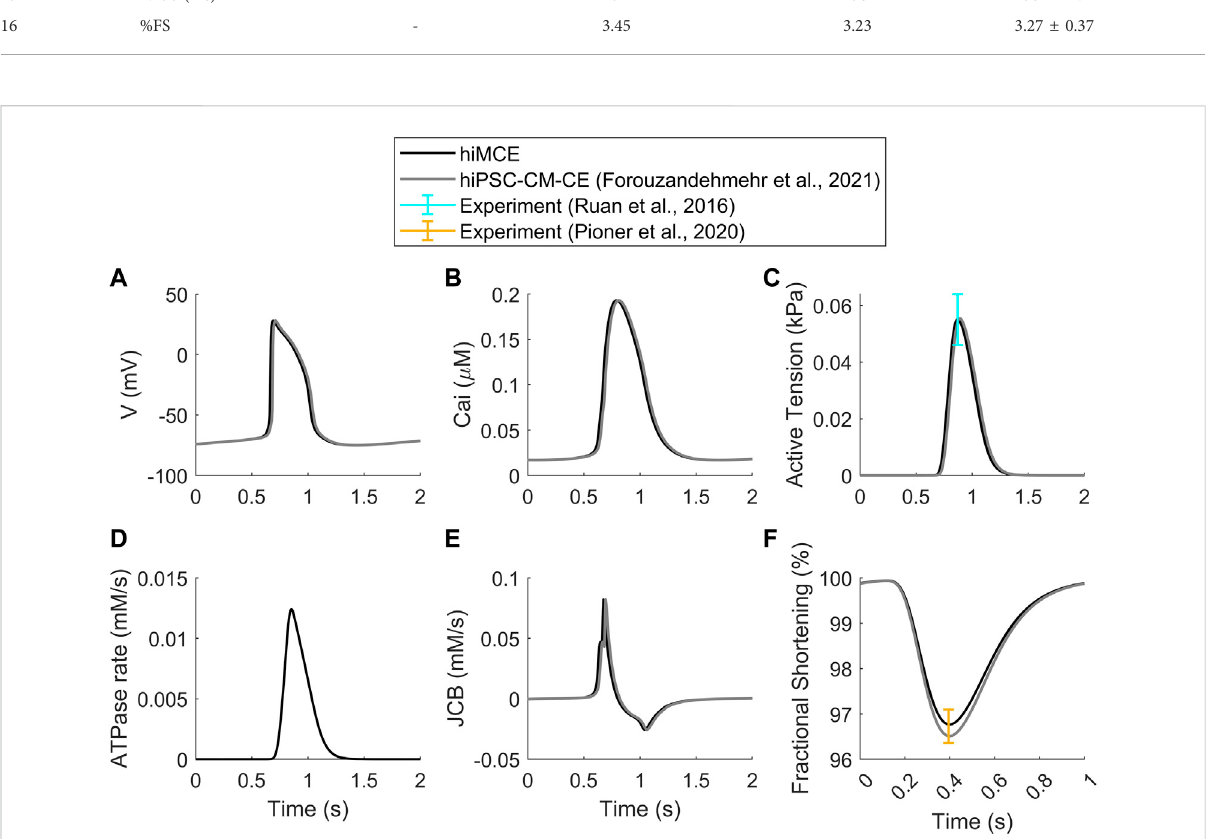
FIGURE 2 Standardresultsofthemodelinspontaneousbeating:ActionPotentials (A) ,Ca 2+ Transients (B) ,ActiveTensions (C) ,ATPaserate (D) ,FluxofCa 2+ towards the contractile element (E) , Fractional cell shortening at 1 Hz pacing (F) . Cited works: (Ruan et al., 2016; Pioner et al., 2020; Forouzandehmehr et al., 2021).